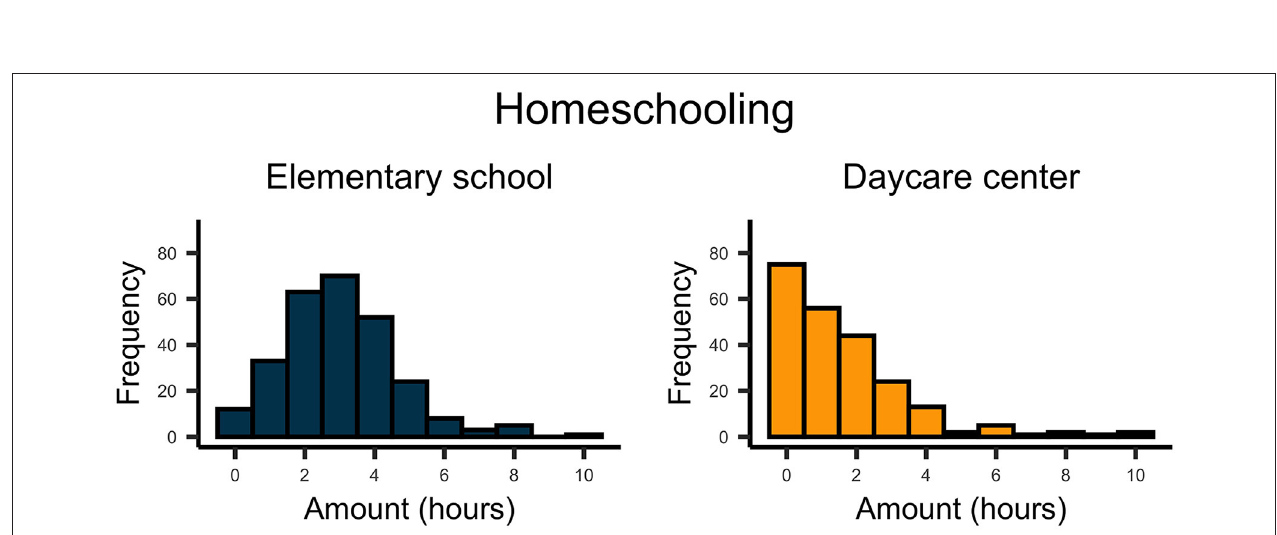
FIGURE 3 | Plots indicate the number of hours parents currently spent for homeschooling with their school- and preschool-aged children.